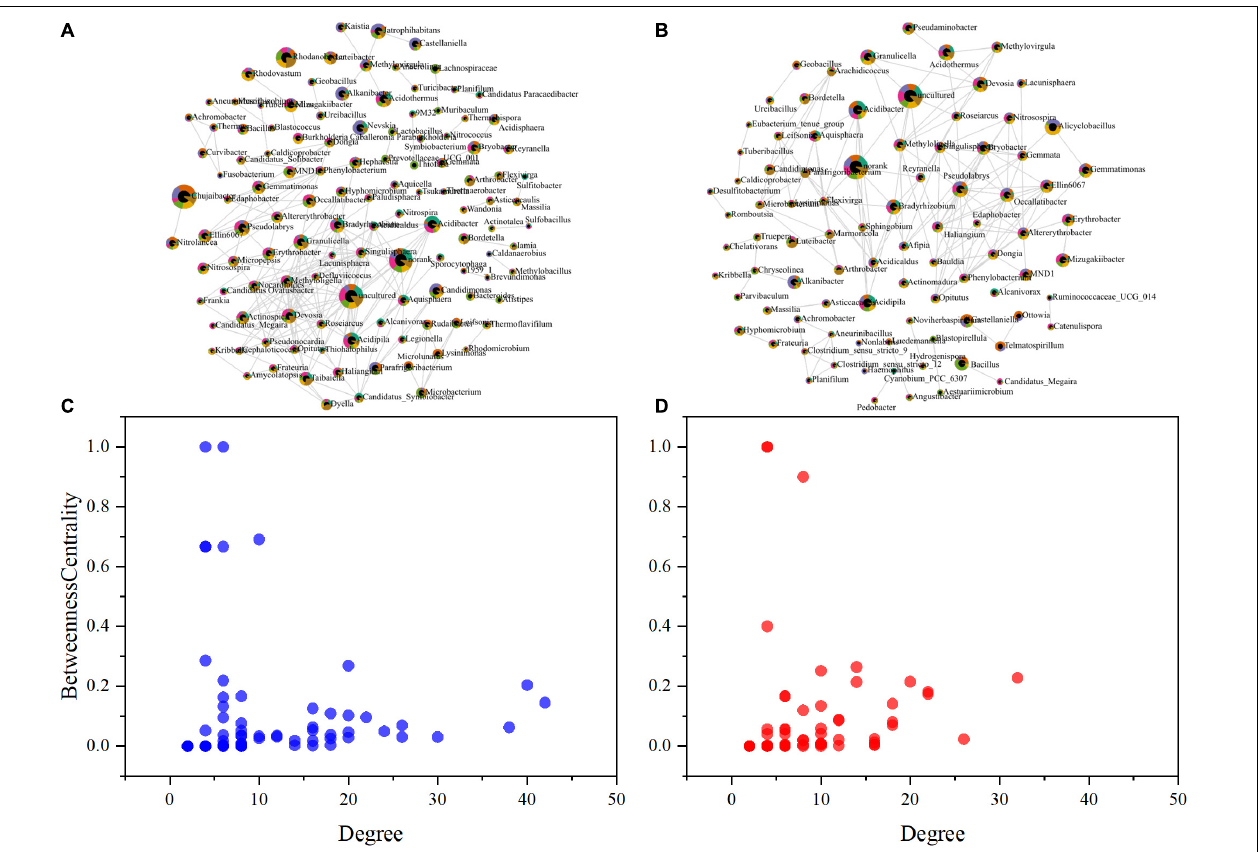
FIGURE 4 | Co-occurrence network analysis showing the biological interactions at the family level under the treatment of selenite (SeO 32 - ) (A) and selenium nanoparticles (SeNPs) (B) . The size of the nodes is relative abundance. The scatter plot shows criteria of selecting for the keystone taxa in SeO 32 - (C) and SeNP (D) networks.